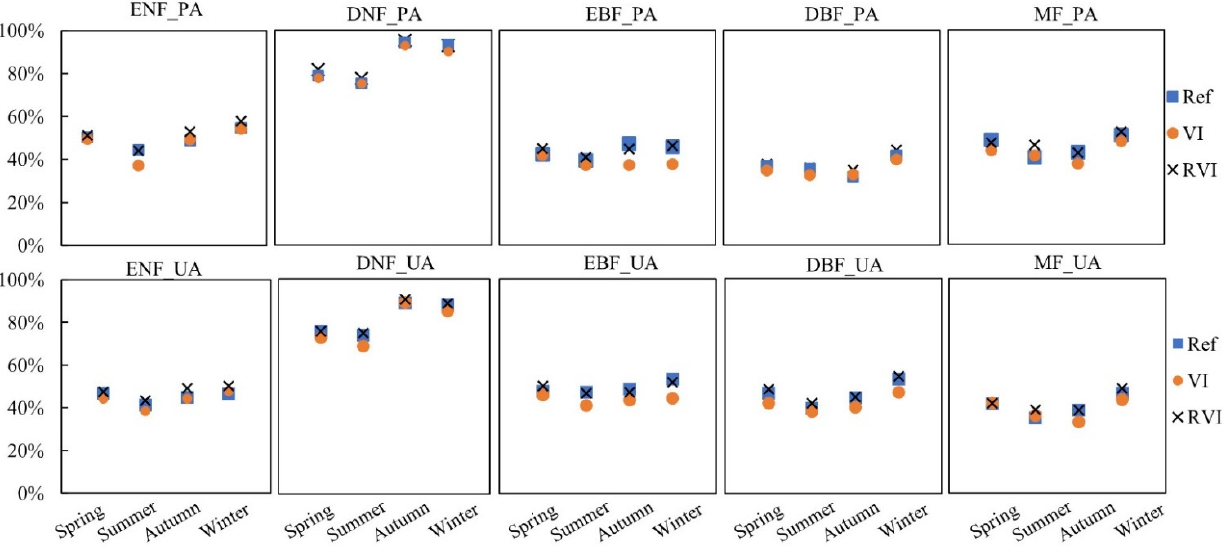
Figure 11. The accuracy comparison of four seasonal single-season composite images on 7 spectral- reflectance bands, 5 VI bands, and the combination of bands of spectral reflectance and VI, respec- tively.